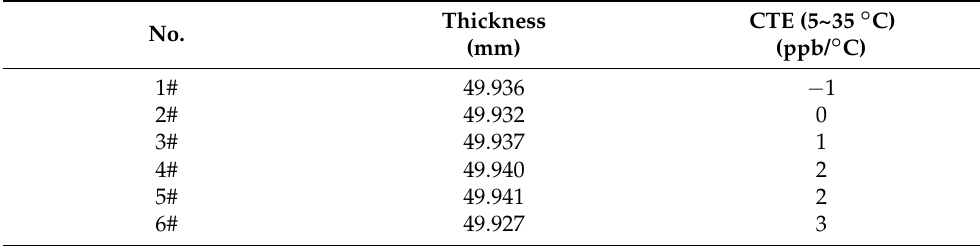
Figure 3. The prepared ULE glass samples: ( a ) source of samples; ( b ) photograph of samples. Table 1. The important parameters of the ULE samples.